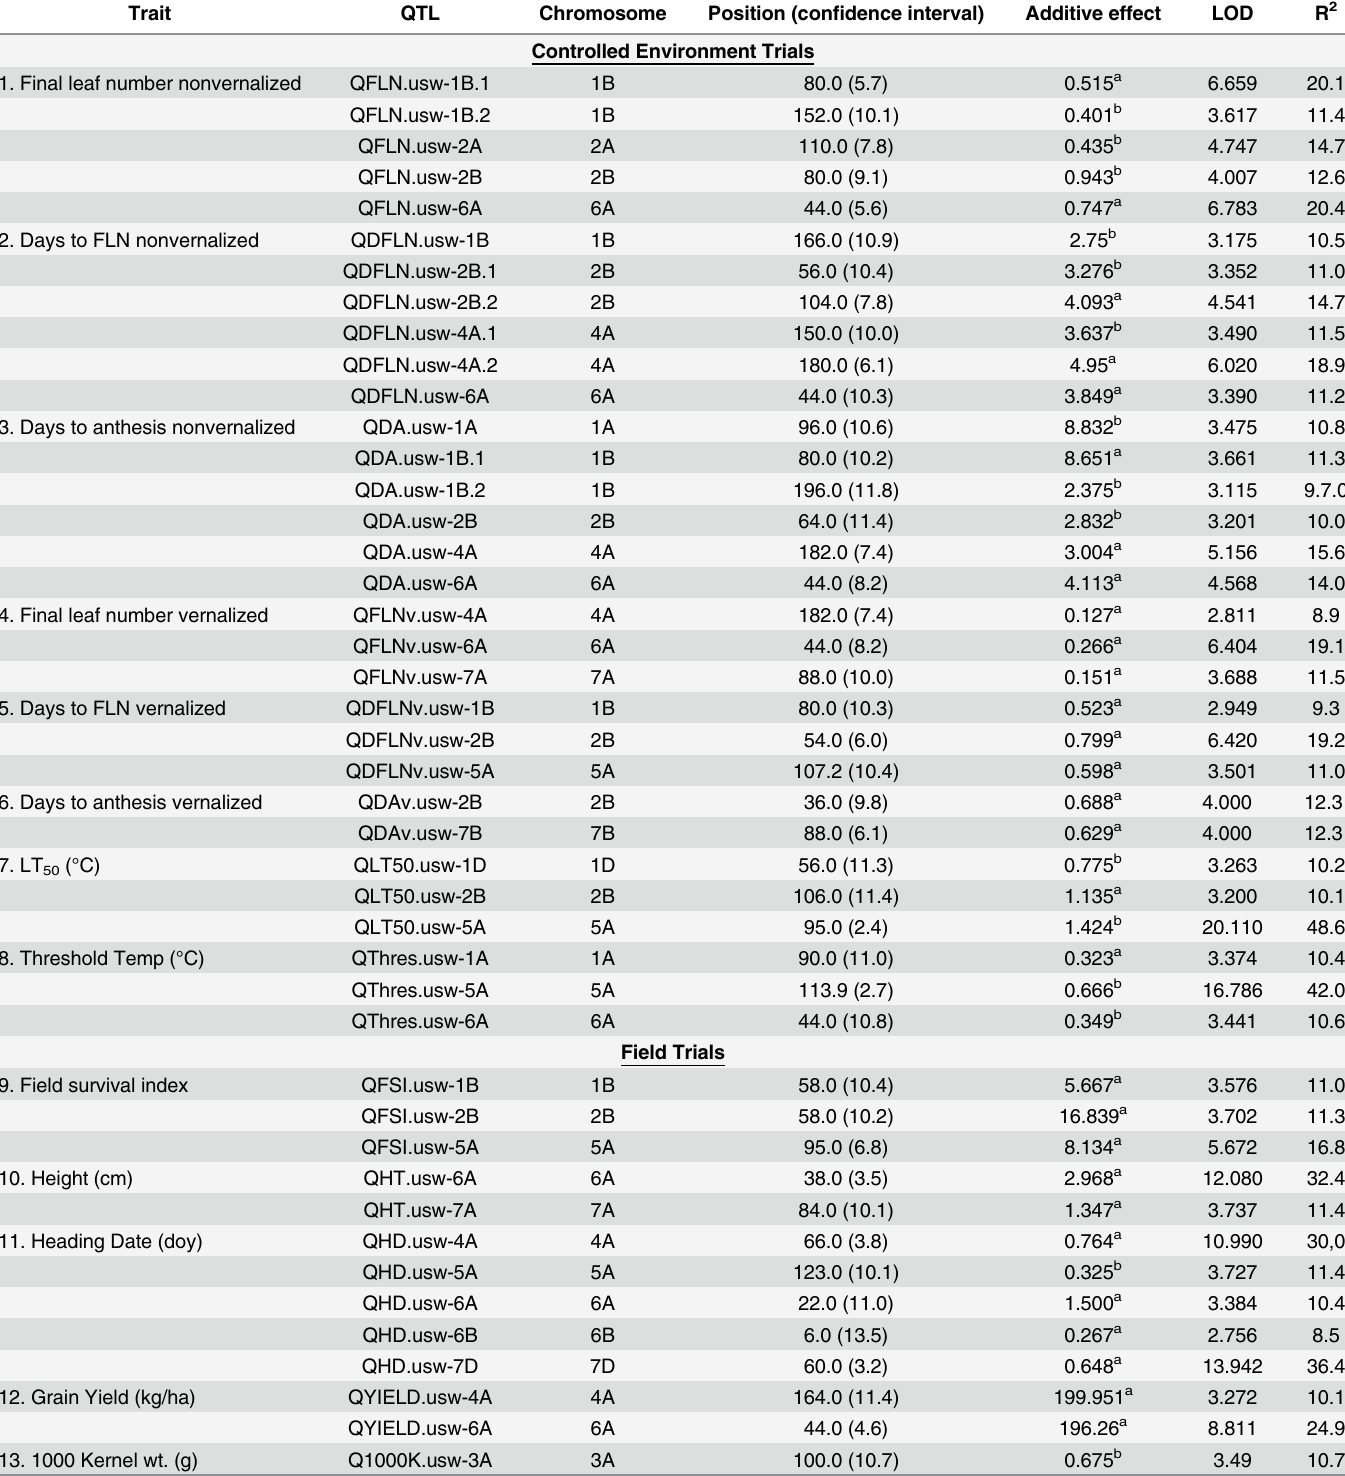
Table 4. QTL Norstar by winter Manitou summary. Position (cM) is given at the peak of LOD with the confidence interval (cM). Additive effect is given according to the parent, Norstar (a) and winter Manitou (b).